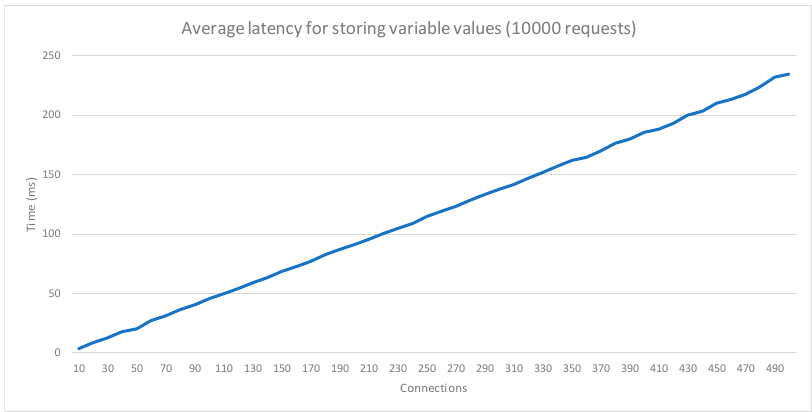
Figure 13. Latency for the acquisition module.